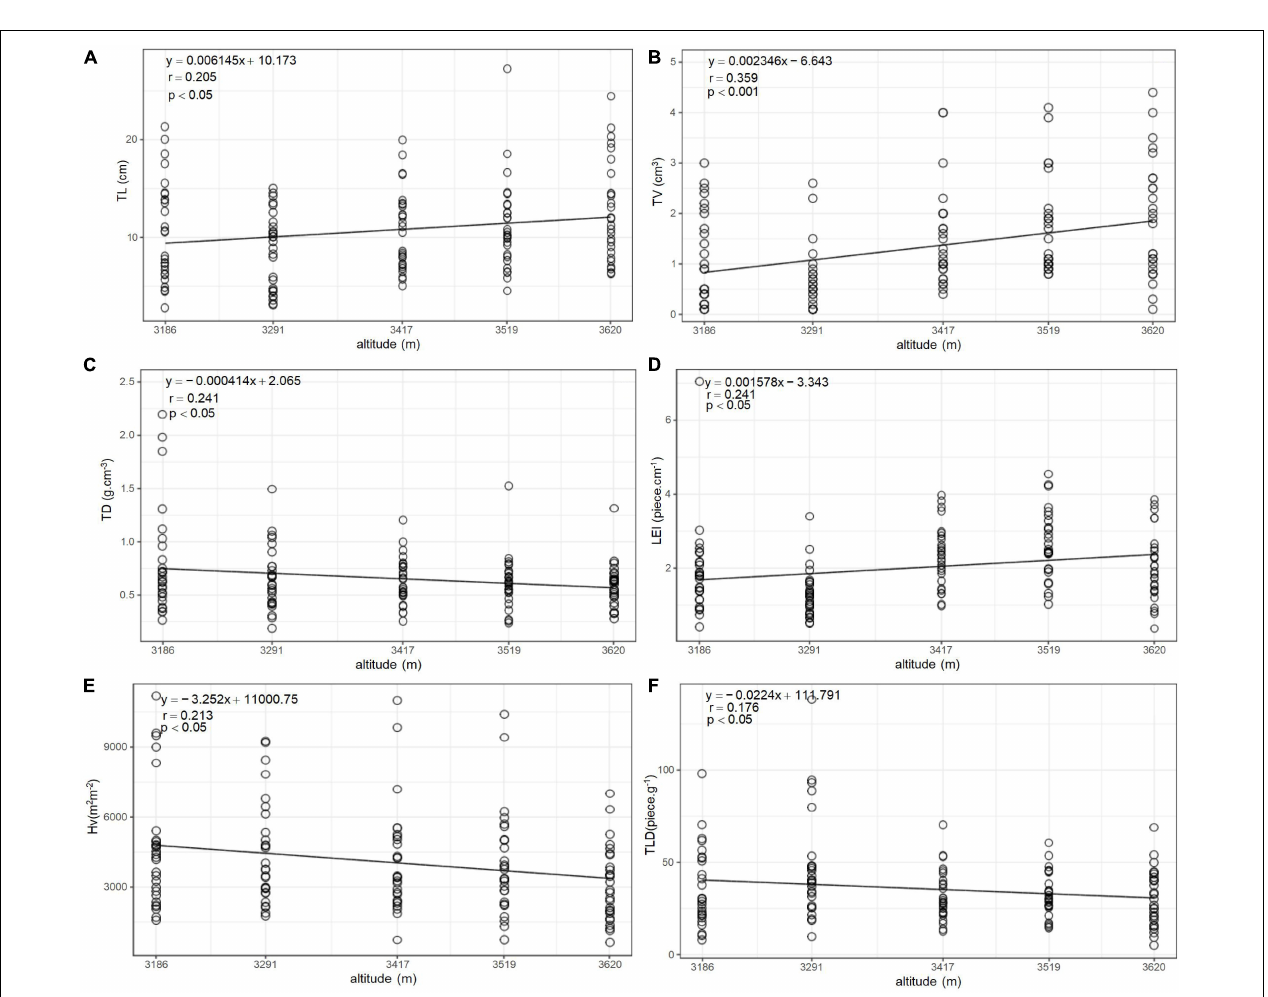
FIGURE 2 | Altitudinal distribution of twigs functional traits of Quercus aquifolioides in Southeastern Tibet. (A) Altitudinal distribution of twig length (TL); (B) altitudinal distribution of twig volume (TV); (C) altitudinal distribution of twig tissue density (TD); (D) altitudinal distribution of intensity of leaf growth based on twigs (LEI); (E) altitudinal distribution of Huber value (HV); and (F) altitudinal distribution of leafing intensity (TLD).